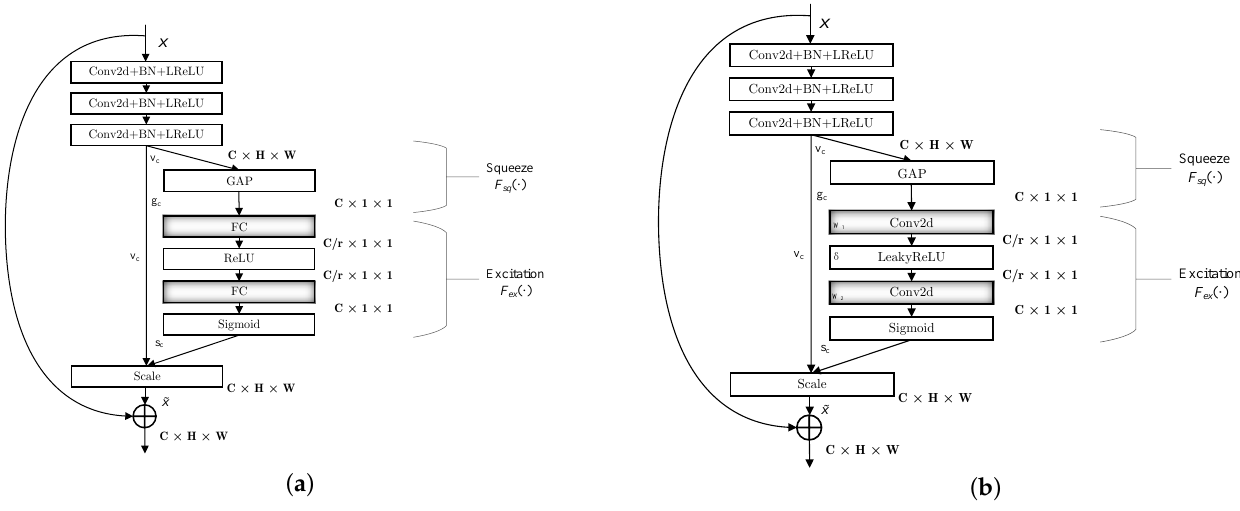
Figure 3. Improved SE-Resnet and Original SE-Resnet modules. “ ⊕ ” represents addition operation. ( a ) Original SE-ResNet module. ( b ) Improved SE-ResNet module (encoding